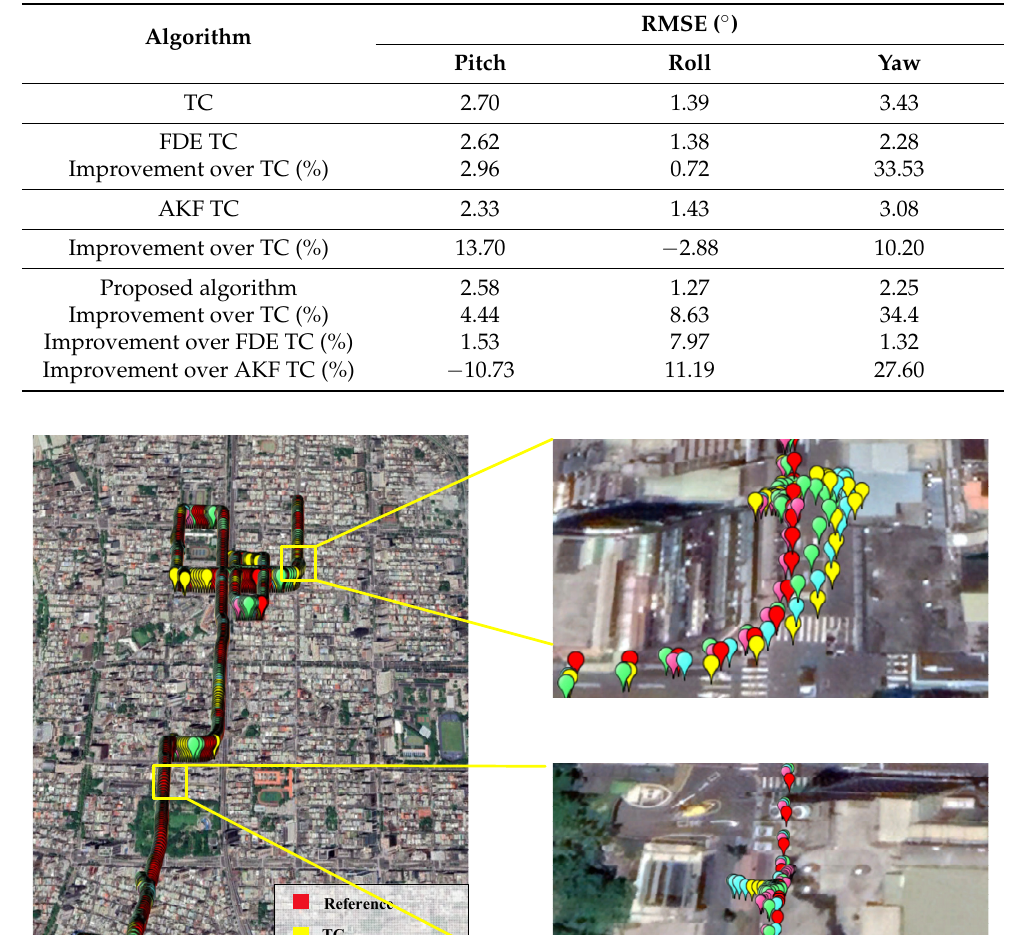
Table 6. The altitude RMSE of TC, FDE TC, AKF TC, and the proposed algorithm in field test.